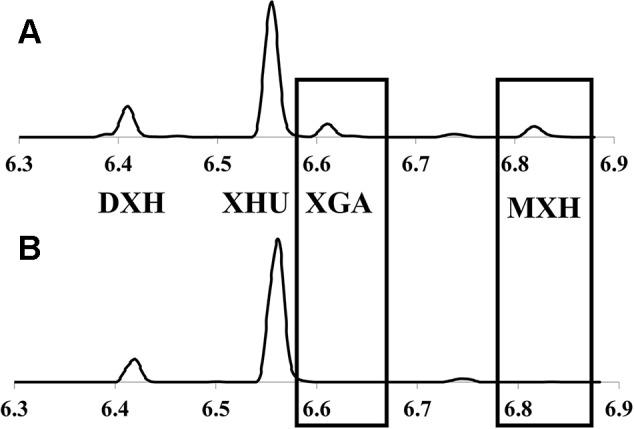
Representative UPLC-DAD chromatograms (370nm) of hops cone prenylchalcones showing: (A)
lupuloides-chemotype profile possessing xanthogalenol (XGA) and 4’-O-methyl xanthohumol (MXH); and (B)
lupulus-chemotype profile lacking these chemotaxonomic markers. XHU, xanthohumol; DXH, desmethylxanthohumol.